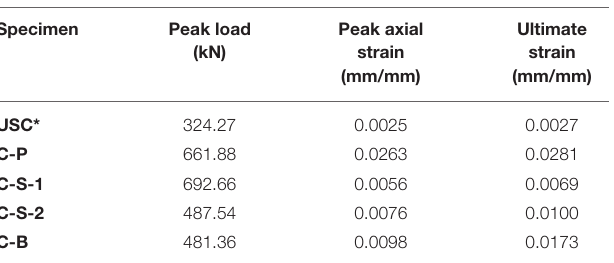
FIGURE 11 | Un-confined columns: experimental vs. numerical axial stress-axial strain